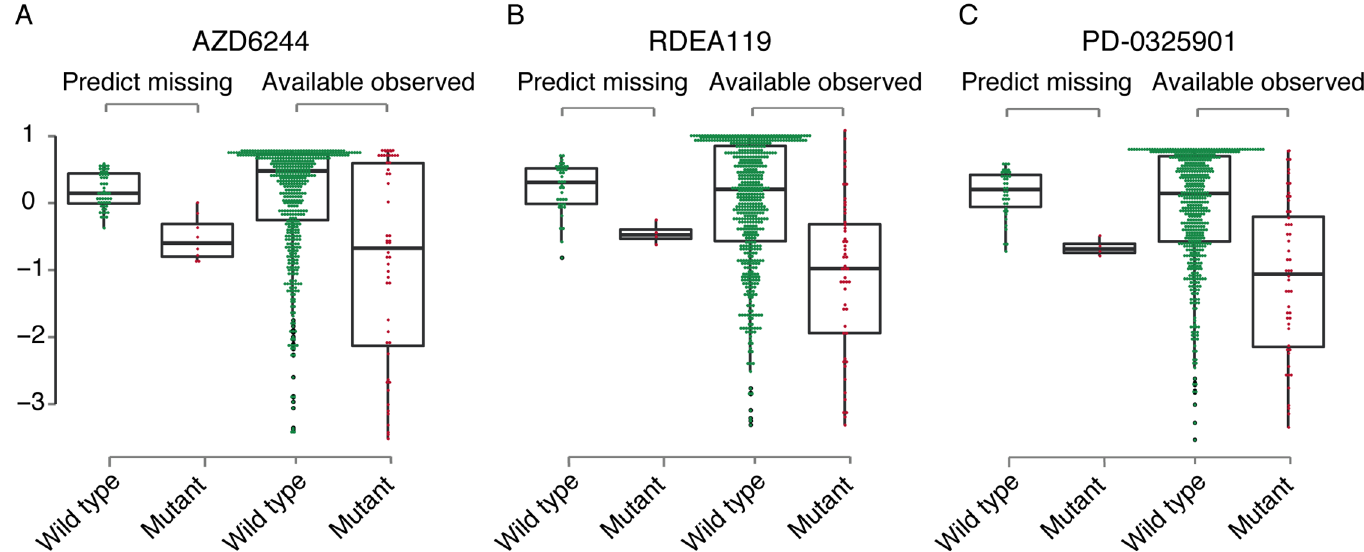
Fig 6. Comparison of predicted and observed activity areas using the dual-layer integrated cell line-drug network model for BRAF mutant and wild-type cell lines for which experimental activity areas was missing from the CGP dataset for three MEK1/2-inhibitors, including (A) AZD6244, (B) RDEA119 and (C)